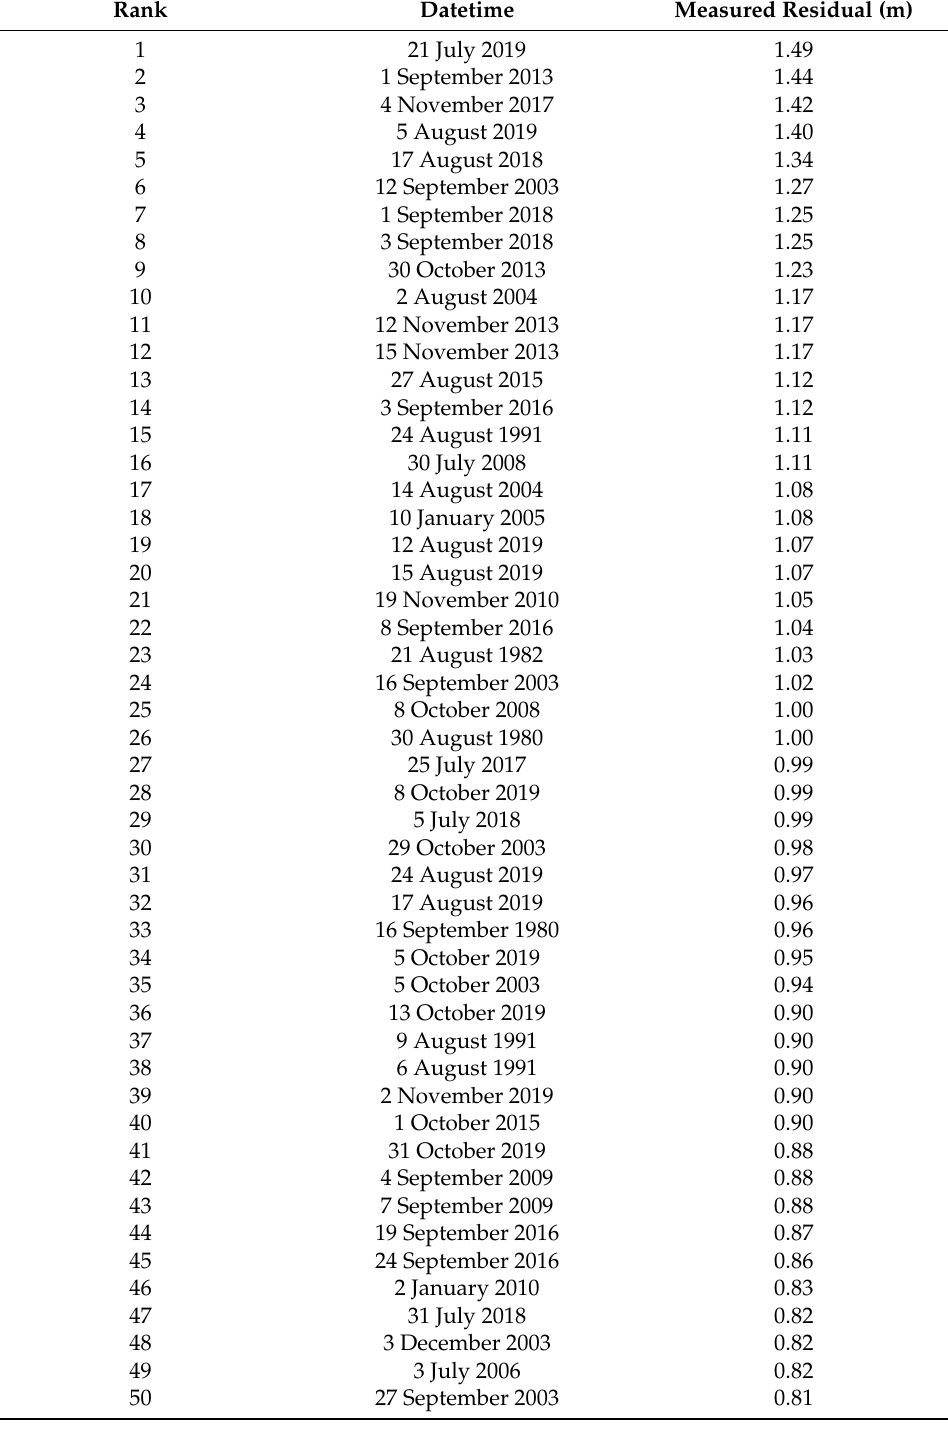
Table A1. The fifty highest positive water-level residual events captured on Tuktoyaktuk Gauge 6485 that fall within the ERA5 reanalysis time period